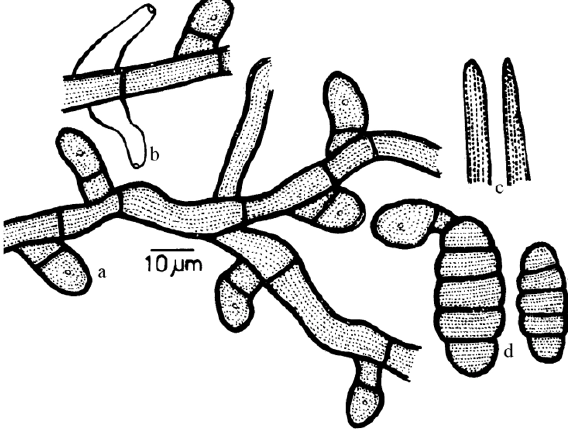
Figure 74. Meliola gamblei a - Appressorium; b - Phialide; c - Apical portion of mycelial setae; d - Ascospores